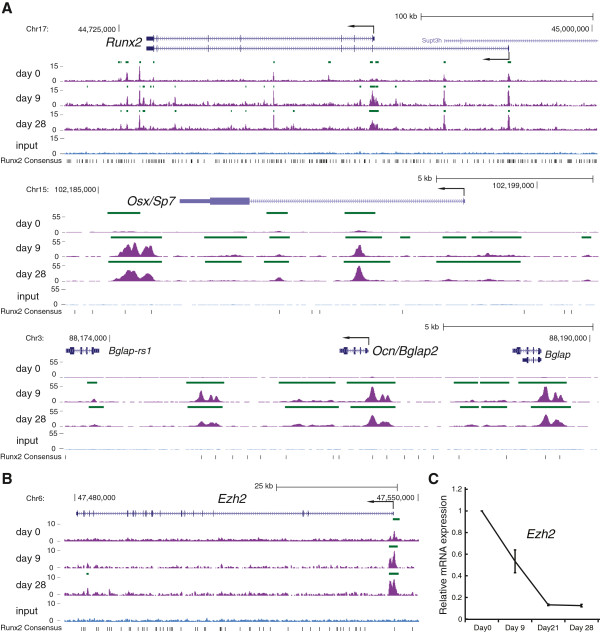
Runx2 binding at known osteogenic genes and a potential target, Ezh2, during osteoblastogenesis. (A) Runx2 binding at three known osteogenic genes, Runx2, Osx, and Ocn, during three stages of osteogenesis: proliferation (day 0); matrix deposition (day 9); and mineralization (day 28). Gene annotation follows standard gene prediction display conventions used by the UCSC genome browser (exons, solid boxes; introns, solid lines; direction of gene transcription, arrows). Positions of Runx2 peaks called by MACS (green bars) and Runx2 consensus motif (TGTGGT; solid black bar) are also depicted. (B)Ezh2 locus bound by Runx2 with increasing Runx2 enrichment over temporal stages of osteogenesis. (C)Ezh2 expression during osteogenesis (relative to day 0 levels) were determined by quantitative RT-PCR and normalized by Hprt1 mRNA levels. Relative mRNA levels are plotted as mean ± SEM from three independent biological replicates.